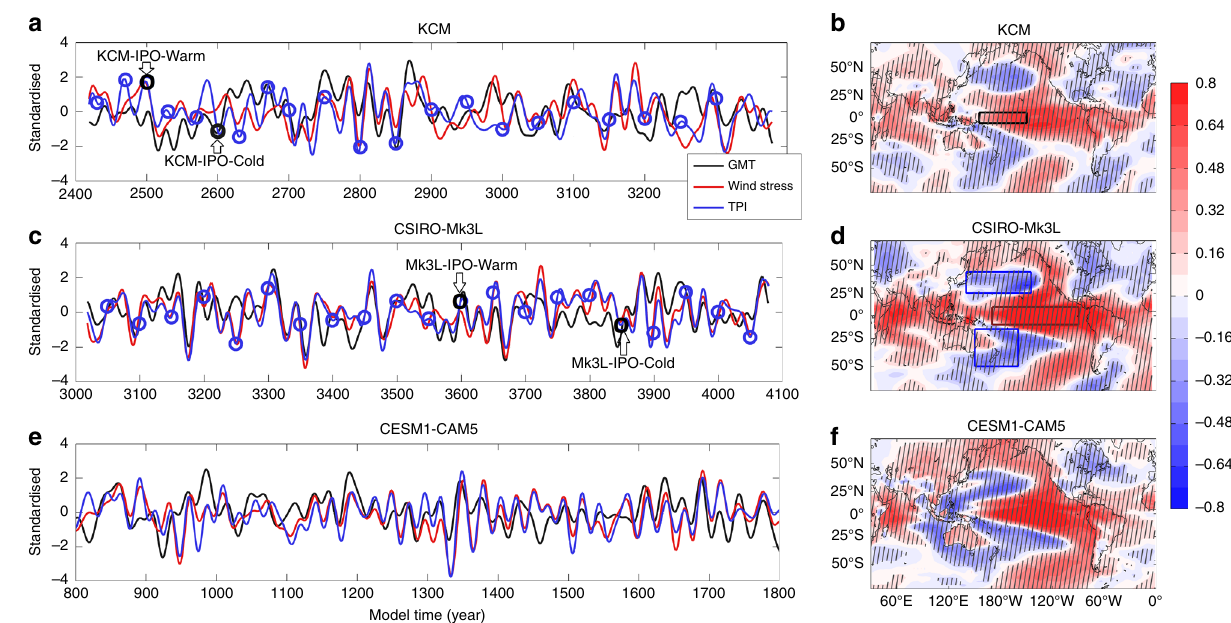
Fig. 1 Time series of tropical Paci fi c zonal wind stress, globally averaged SAT, and the Tripole Index in the three climate models. Time series of low- frequency fl uctuations (11-yr low passed fi lter) in ( a , c , e ) zonal wind stress over western equatorial Paci fi c (red solid lines), globally averaged SAT (black solid lines), and the Tripole Index (TPI; blue solid lines) from a KCM, c Mk3L, and e CESM-CAM5 control runs (all time series have been standardized). Blue (black) circles in a and c denote the initial year of the KCM-ICs (the KCM-IPO-Cold and the KCM-IPO-Warm) and the Mk3L-ICs (the Mk3L-IPO-Cold and the Mk3L-IPO-Warm) global warming simulations, respectively. b , d , f panels display the corresponding correlation between low-frequency fl uctuations in the equatorial zonal wind stress (11-yr low passed fi lter) and local SAT anomalies computed from the control runs. Boxes on d indicate locations used for the calculation of the TPI. Hatching in b , d , f show where the correlation is statistically signi fi cant at 99% con fi dence level (accounting for autocorrelation in the time